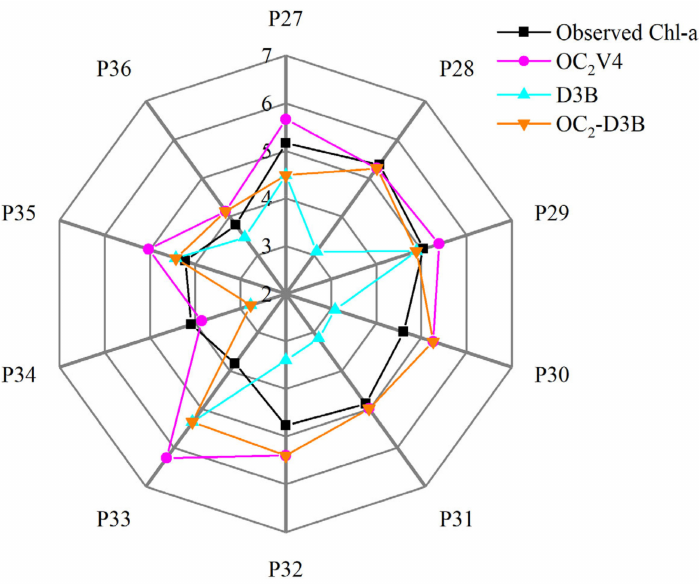
Figure 9. Estimated chl-a concentration versus in situ measured chl-a concentration (P denotes sample site